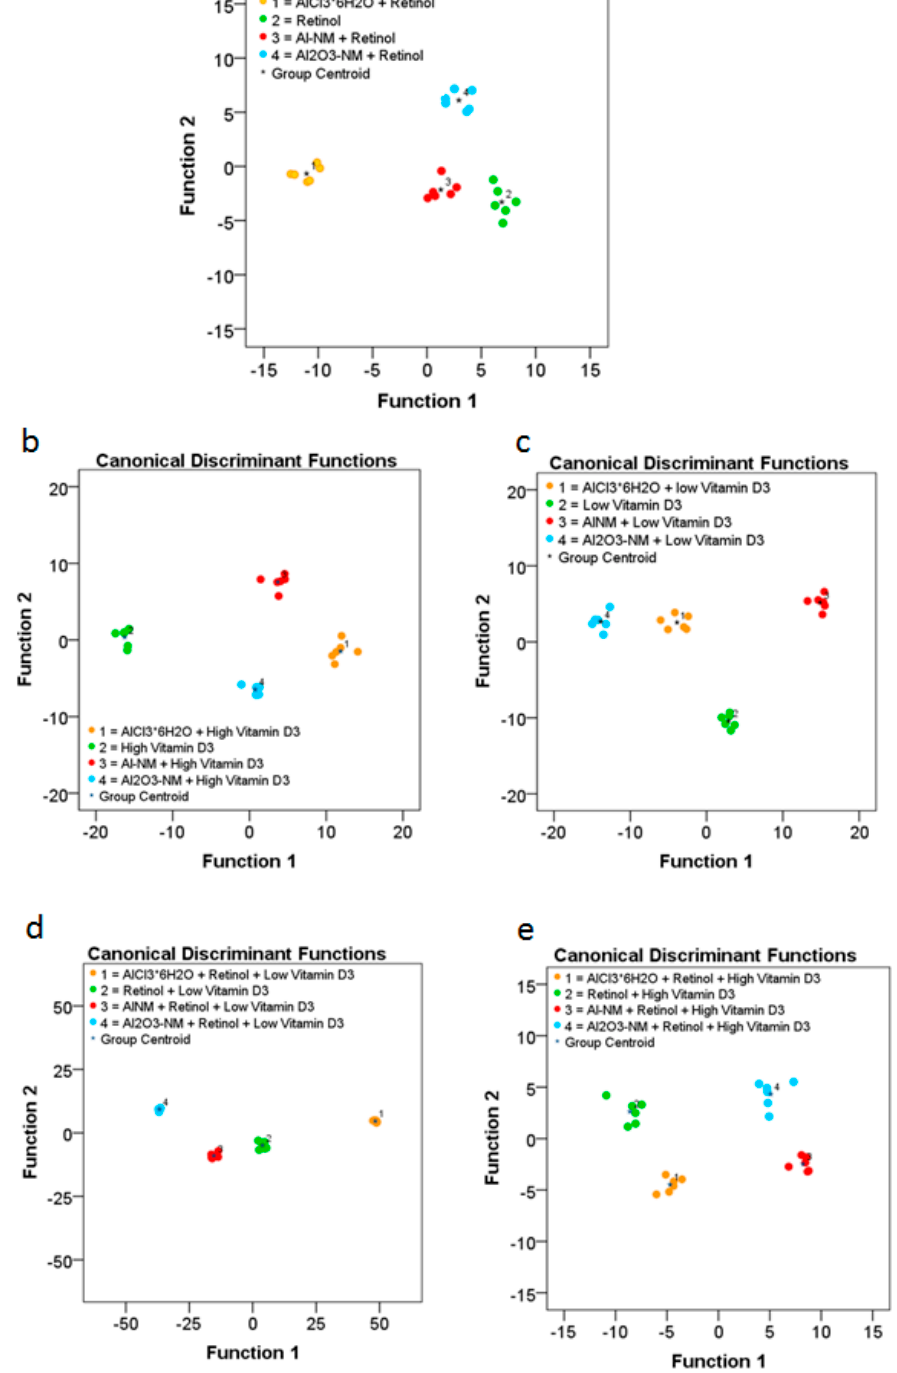
Figure 7. ToF-SIMS analysis of changes in the composition of the cell membranes of HaCaT cells after treatment with Al or Al 2 O 3 NMs and ionic AlCl 3 · 6H 2 O without or in combination with vitamins (( a ) retinol; ( b ) high vitamin D3; ( c ) low vitamin D3; ( d ) retinol plus low vitamin D3; ( e ) retinol plus high vitamin D3). The diagram shows the values of the discriminant scores obtained from Fisher’s discriminant analysis of 24 single HaCaT cells for each experiment. The performance of the discriminant model was verified by applying the cross-validation procedure based on the “leave-one-out” cross-validation formalism (100%).